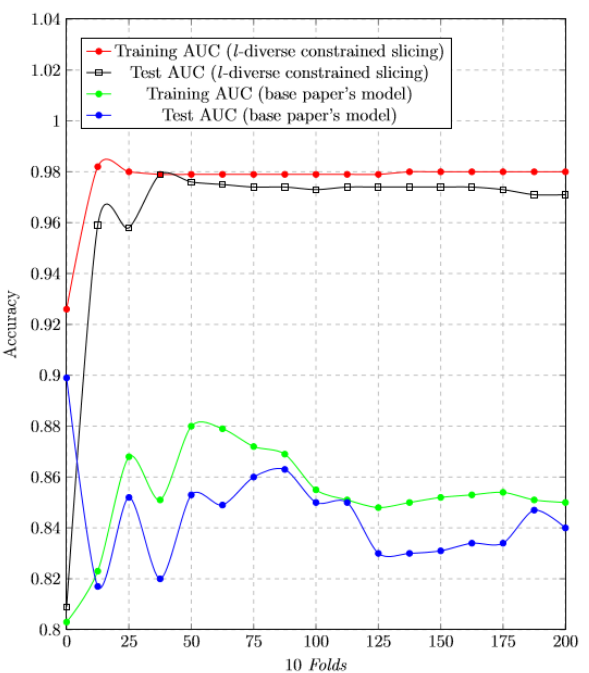
Figure 6. RF classification report— l -diversity constrained slicing graph comparison with base paper model.